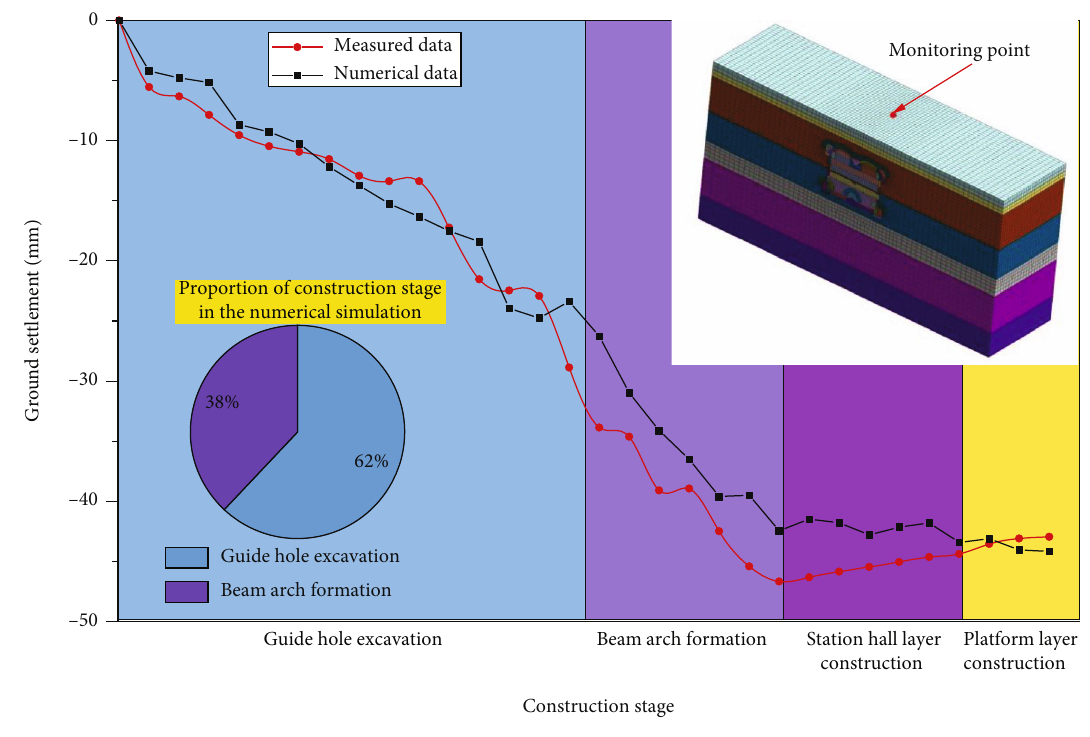
Figure 10: Ground surface settlement process.